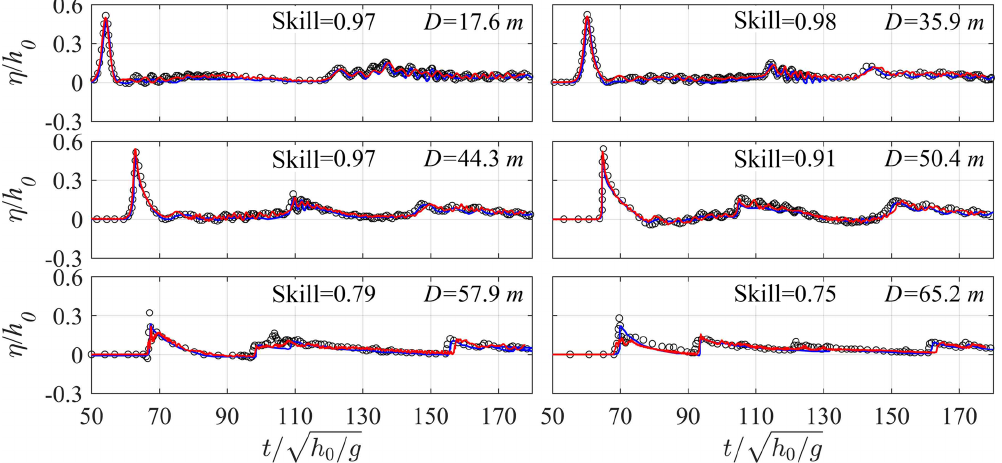
Figure 5. Time series of dimensionless free-surface elevations ( η/h 0 ) at different cross-shore distances from the wavemaker ( D ) for Sce- nario 1. Red lines – present simulations; blue lines – simulations from Roeber (2010); open circles – measurements from Roeber (2010); skill values are for the present